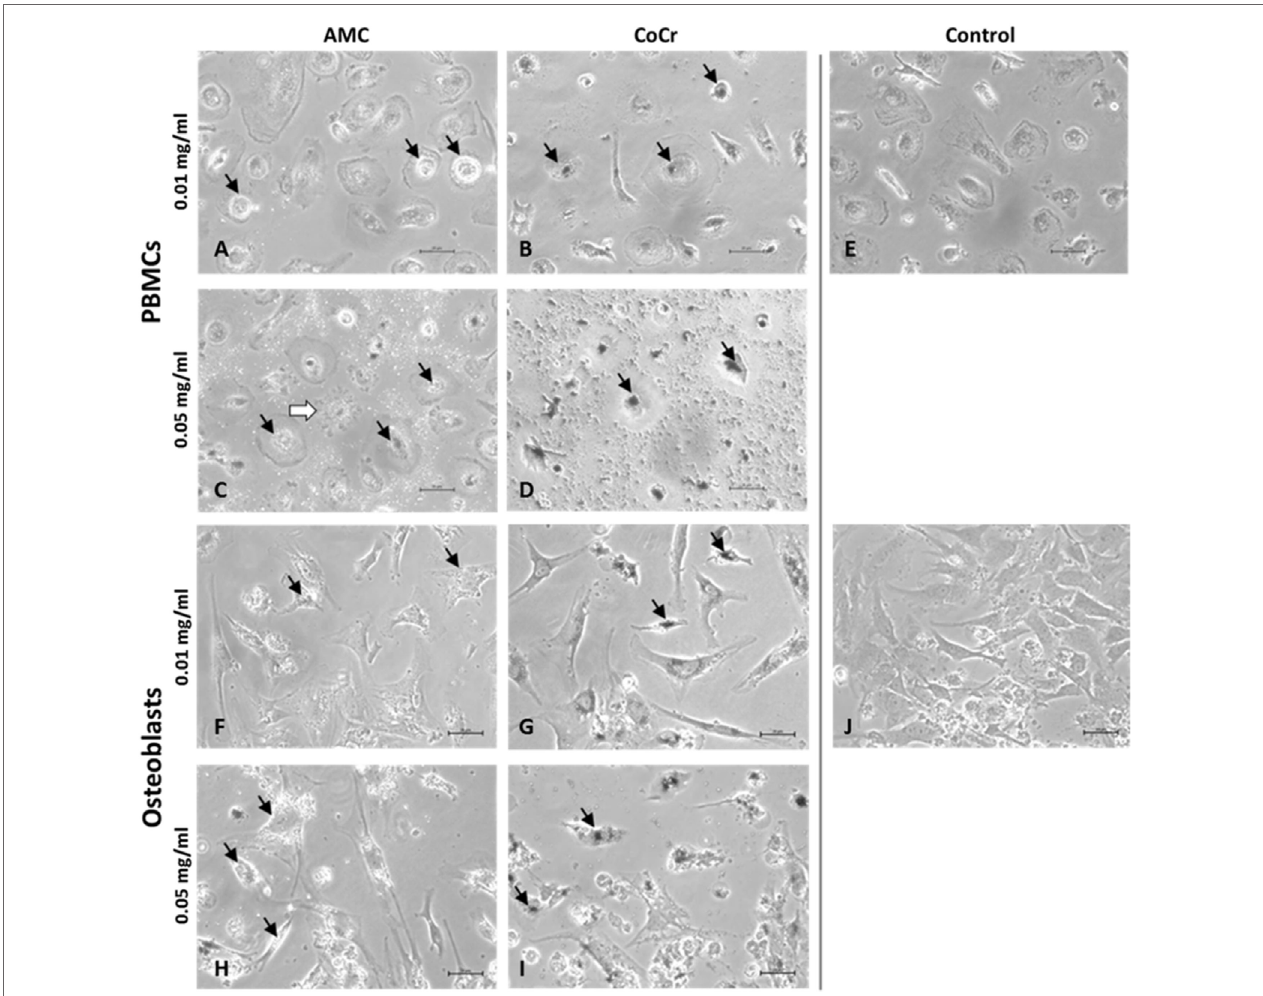
FigUre 2 | Representative pictures of human PBMCs (a–e) and osteoblasts (F–J) after exposure to AMC and CoCr particles. Cells were treated with the respective particle type using different concentrations over a period of 48 h. Particle accumulations are highlighted with black arrows. Light microscopy revealed either particle- or concentration-dependent effect on cell density and morphology. Bar: 20